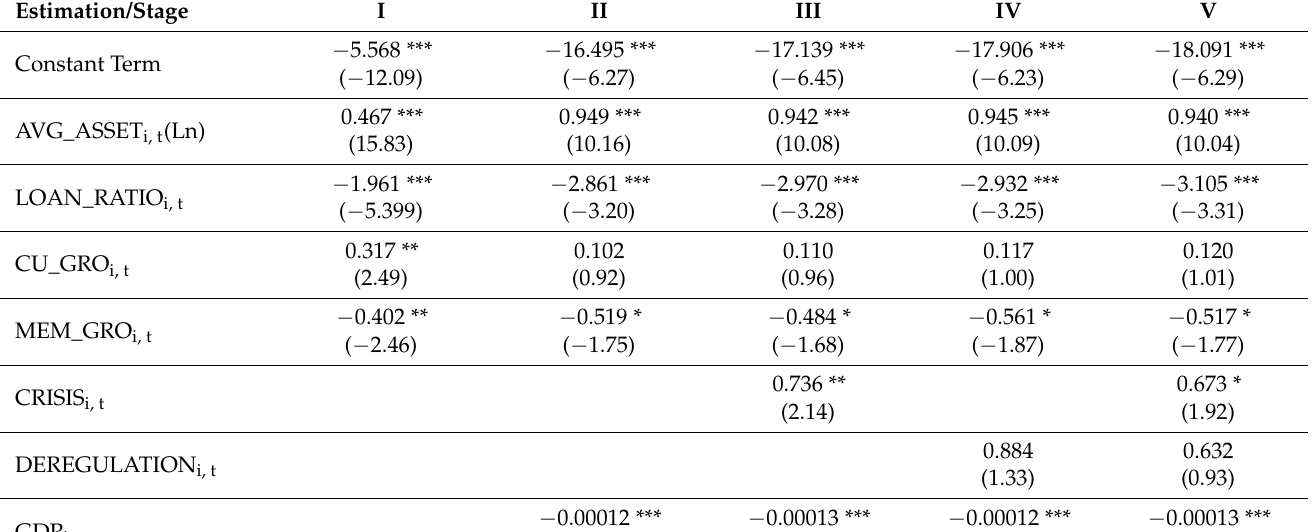
Table 7. Estimated results of the binary logistic regression (from the nascent stage to the transi- tion